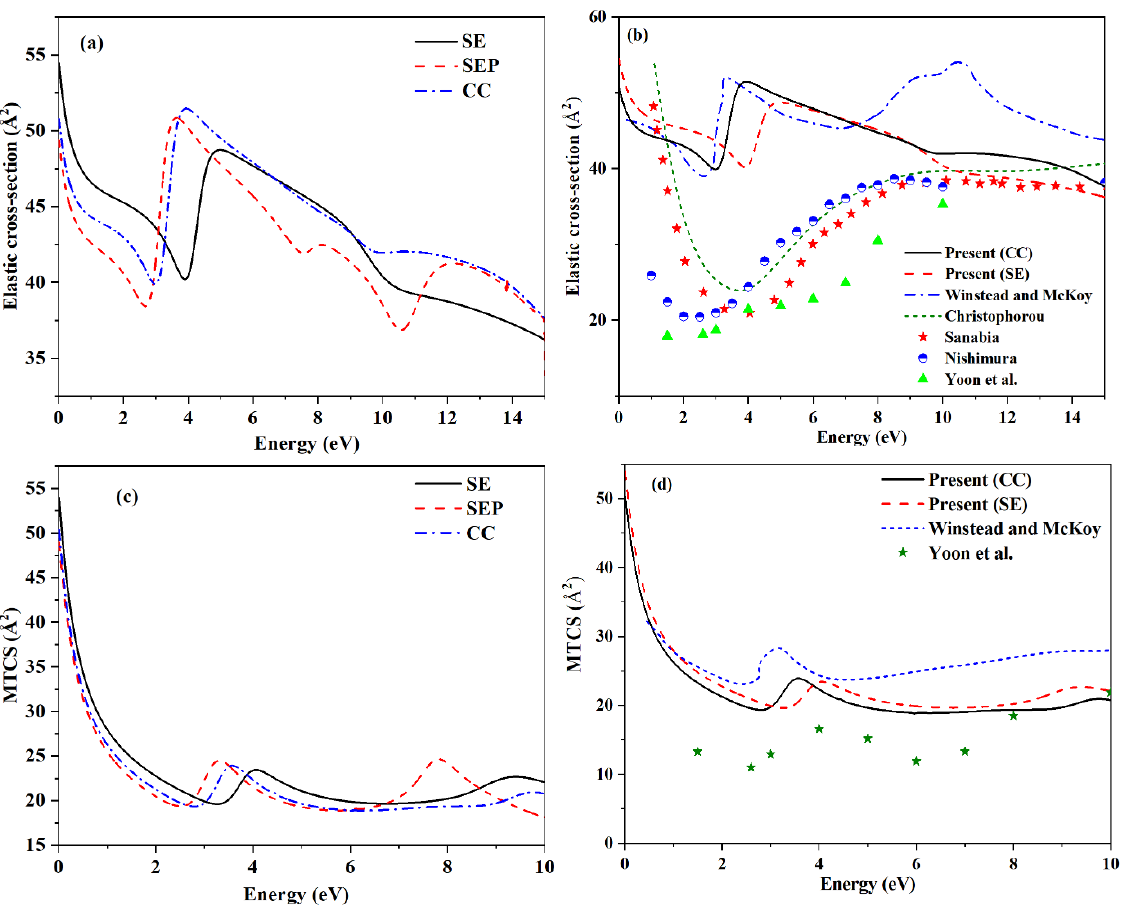
Figure 3. Elastic and momentum transfer cross-section of c -C 4 F 8 scattering; ( a ) comparison among the different models (SE, SEP, and CC) for the elastic cross-section; ( b ) comparison of the present elastic cross-section (SE and CC) with the available data in the literature; ( c ) comparison among the different models (SE, SEP, and CC) for the MTCS; ( d ) comparison of the present MTCS (SE and CC) with the available data in the literature.